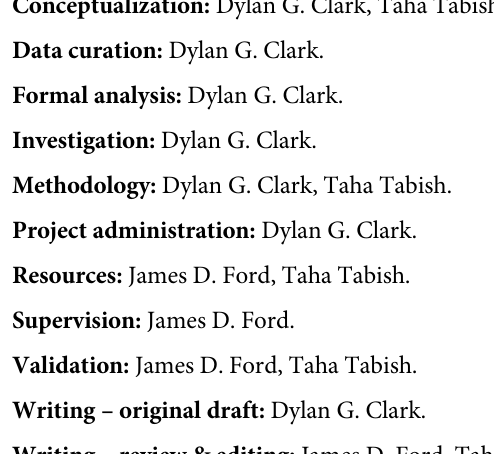
S4 Fig. Three-dimensional rendering. This photo captures the power of the three-dimension meshing produced using UAV images taken at approximately 75’ above ground level. In this photo you can see a wooden cabin, ATV trail, shore line dropping off to the right of the photo, and the visible sand and rock pits in the foreground. Photo generated by Dylan G. Clark, with approval to distribute under the CC BY